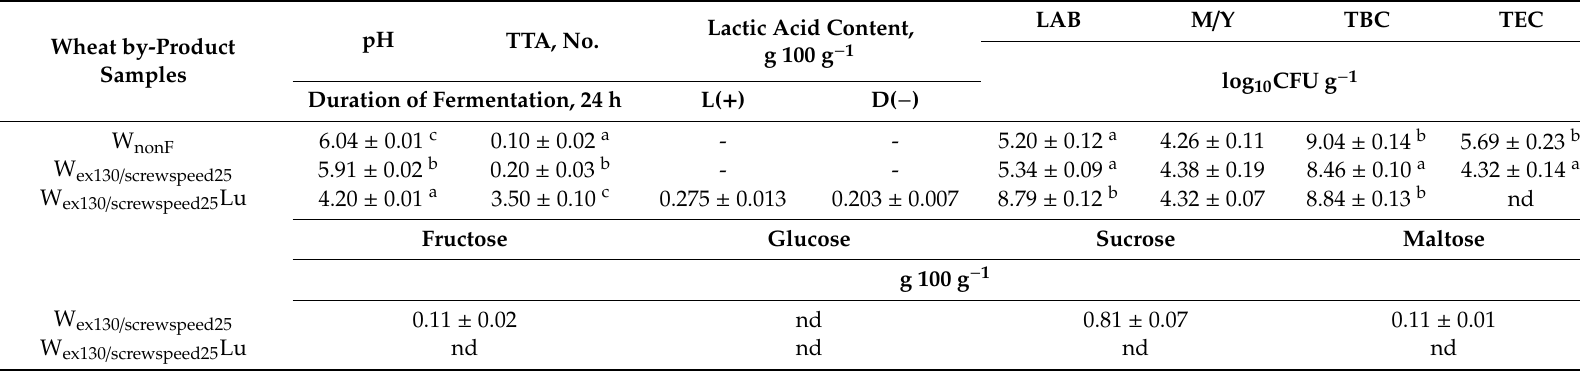
Table 3. Acidity (pH, total titratable acidity (TTA), and lactic acid isomers concentration) and microbiological parameters (lactic acid bacteria (LAB), mould / yeast (M / Y), total bacteria (TBC), and total enterobacteria (TEC) count) of the extruded and fermented wheat bran.